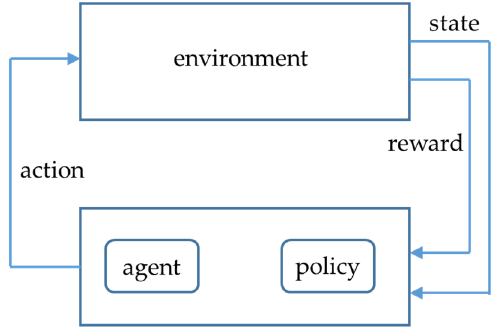
Figure 2. The concept of reinforcement learning.